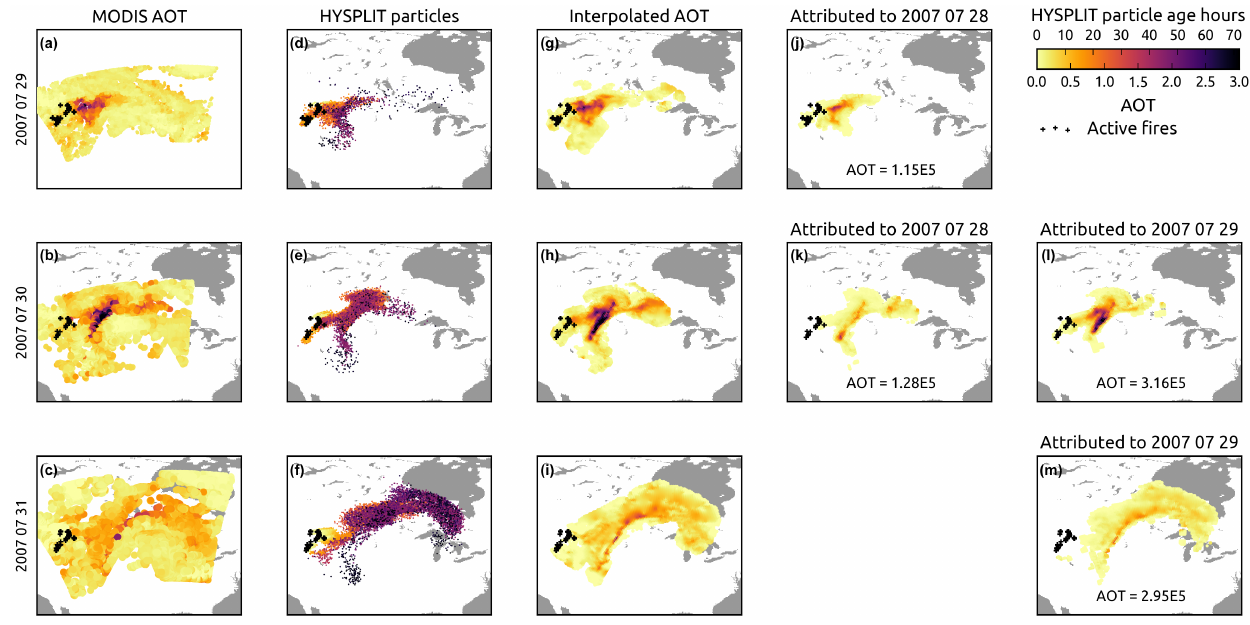
Figure 1. An illustration of the method showing an example of fire-emitted AOT attribution for two diurnal cycles of a temperate fire. Rows in the figure represent 3 successive days of satellite imagery from which the attribution was achieved. Columns from left to right show MODIS AOT retrievals for the day from a single platform with the highest coverage (a–c) , snapshots of HYSPLIT particle positions and age taken at local noon (d–f) , and AOT interpolated to 25km equal-area grid (g–i) . The two right columns show fire-emitted AOT attributed to 28 (j) and (k) and 29 (l) and (m) July 2007 determined from images taken on different days. Total attributed AOT is shown within the